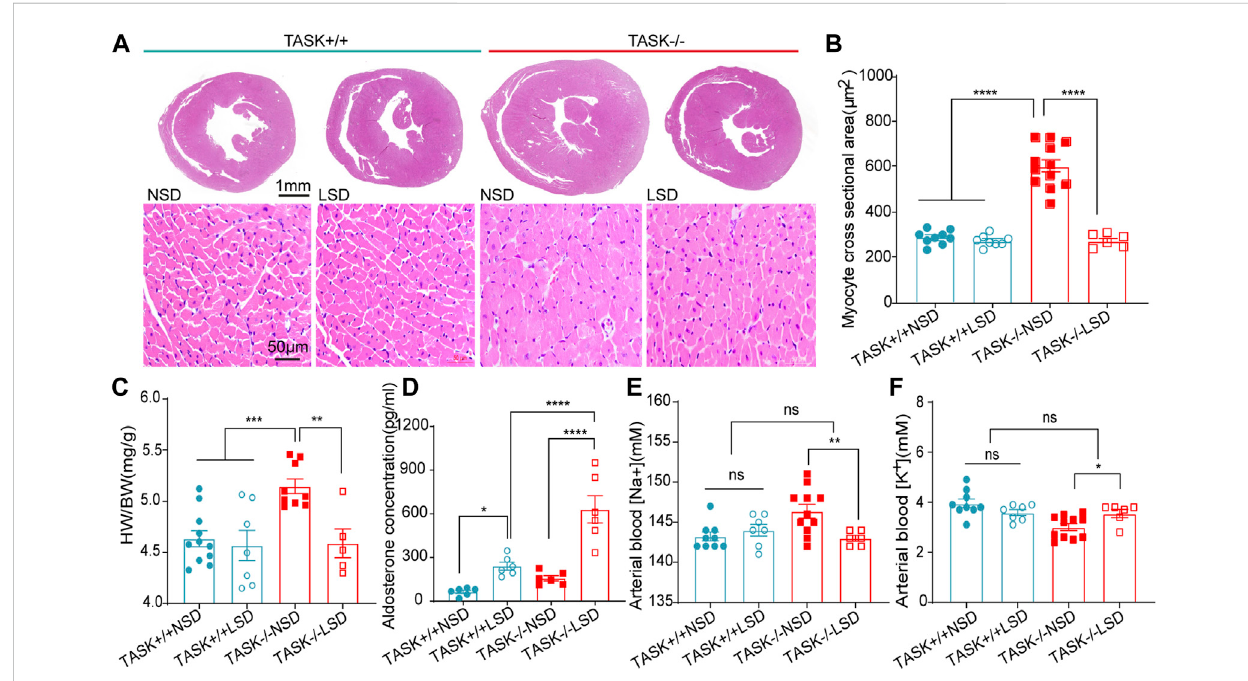
FIGURE 3 Morphological and biochemical analysis. (A) HE staining images of transverse heart sections at the level of the papillary muscle (top images, scale bars: 1 mm) and LV myocyte cross sections (bottom images, scale bars: 50 μ m). Quanti fi cation of average MCSA ( > 50 myocytes per heart) in the randomlyselected fi eld (B) ,**** p < 0.0001,one-wayANOVAwithFisher ’ sLSDtest.TheHW/BW (C) ,plasmaaldosteroneconcentration (D) ,arterialblood Na + (E) and arterial blood K + (F) in TASK +/+ and TASK − / − mice with NSD or LSD (* p < 0.05, ** p < 0.005, *** p < 0.0005, one-way ANOVA with Fisher ’ s LSD